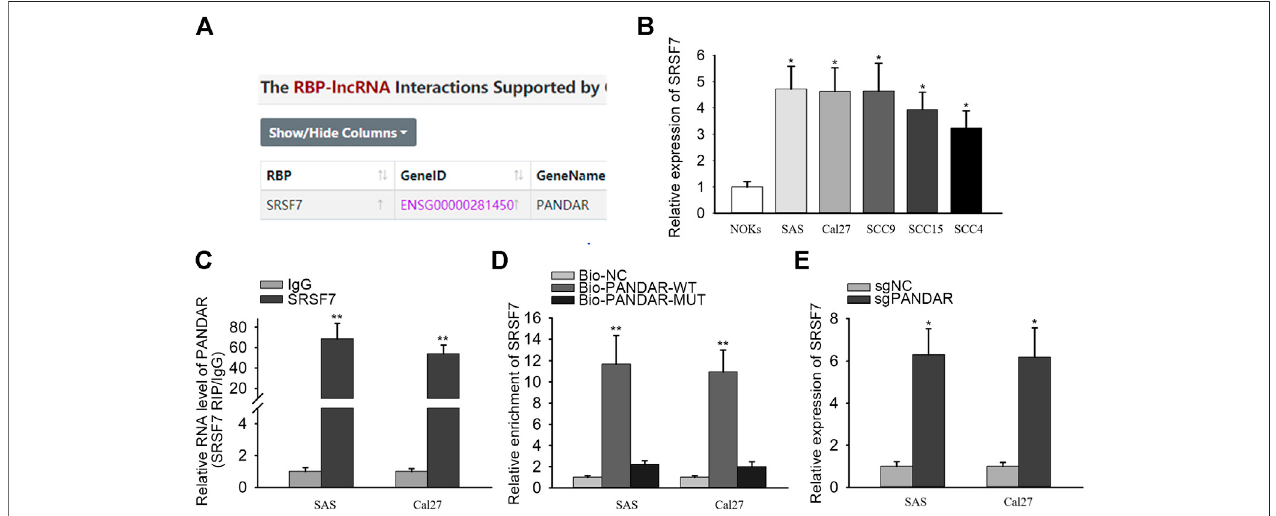
FIGURE2| SRSF7actedasaRBPofPANDARinOSCC.( A) InlinewiththepredictionofstarBase,SRSF7wasfoundtobeaRBPofPANDAR. (B) Theexpression level of SRSF7 in cancerous cells and normal cells. ( C,D) RIP and RNA pull-down assays were conducted for validating the interaction between SRSF7 and PANDAR in OSCC cells. ( E) PANDAR knockdown increased SRSF7 expression in OSCC cells. Data wererepresented as the mean values ( ± SD) ofthree independent experiments. * p < 0.05 and ** p < 0.01, signi fi cantly different from the